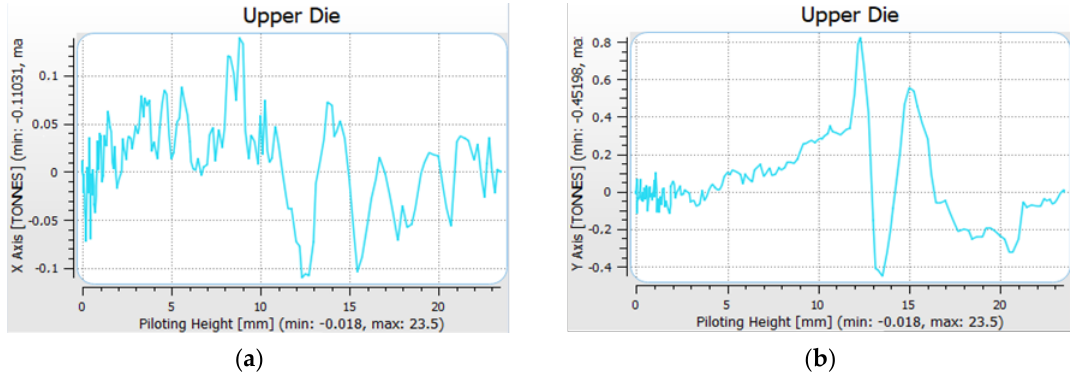
Figure 12. Results of analysis with the use of numerical modelling: ( a ) course of forging forces in the function of displacement in the horizontal direction in axis X, ( b ) in the horizontal direction in axis Y.